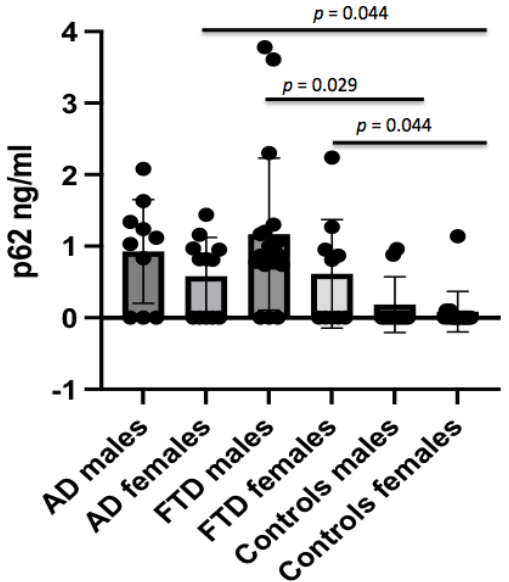
Figure 2. Comparison of p62 concentrations between AD, FTD, and control groups according to gender distribution.